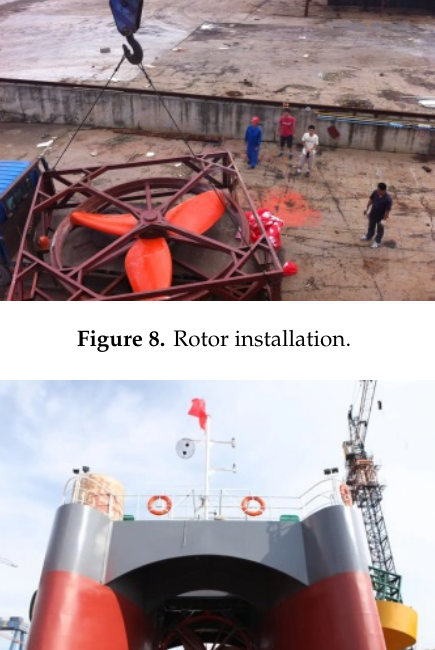
Figure 7. Performance prediction of the blade under different velocities; ( a ) power curve and power coefficient curve at different velocities, and ( b ) thrust curve and thrust coefficient at different velocities.